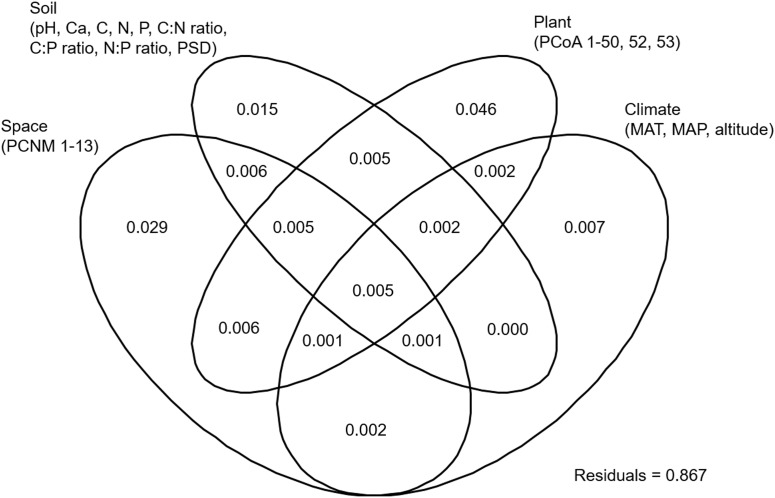
Variation partitioning showing the pure and shared effects of host and abiotic factors on ectomycorrhizal fungal community composition. Numbers indicate the proportions of variation explained. C, total soil carbon; N, total soil nitrogen; P, total soil phosphorus; Ca, total soil calcium; PSD, particle size distribution; PCNM, principal coordinates of neighbor matrices. PCoA, principal coordinates analysis of host phylogeny; MAT, mean annual temperature; MAP, mean annual precipitation.